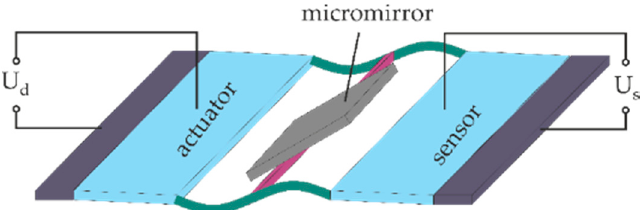
Figure 10. Schematic drawing of realizing micromirror position sensing applying one PZT cantilever as position sensor based on the direct piezoelectric effect ( U d stands for the driving voltage and U s stands for the sensing voltage.)